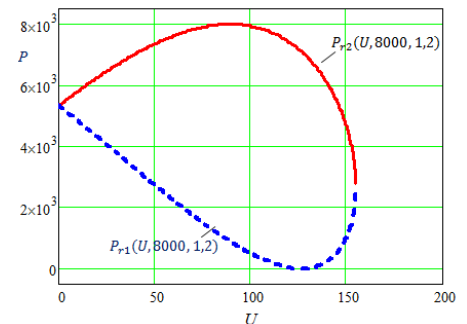
Figure 7. The initial set of the solutions of Equation (8).